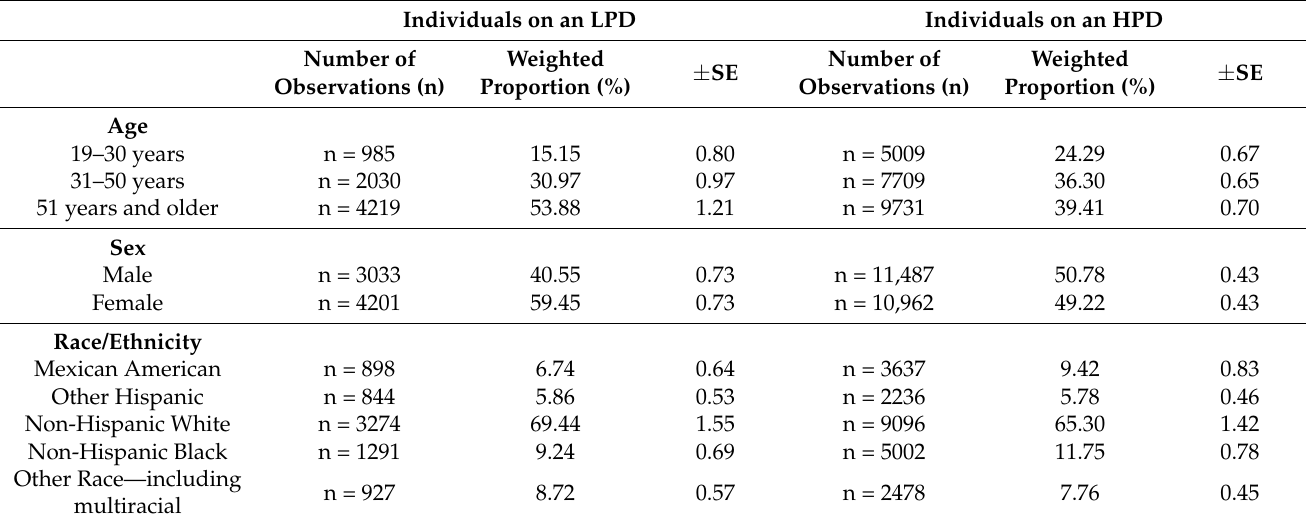
Table 1. Sample characteristics. The sample included n = 7234 participants on an LPD and n = 22,449 participants on an